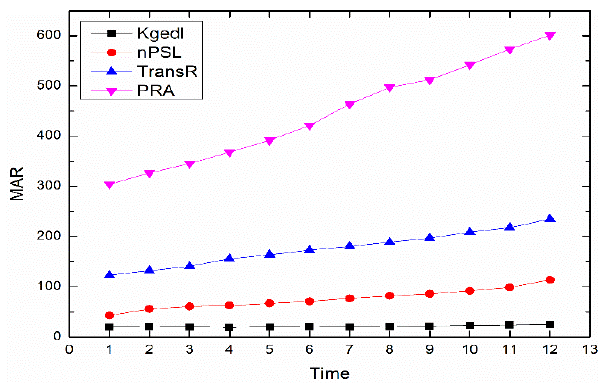
Figure 5. The Mean Absolute Rank (MAR) link prediction comparison result between Kgedl and baseline methods on the YAGO dataset.